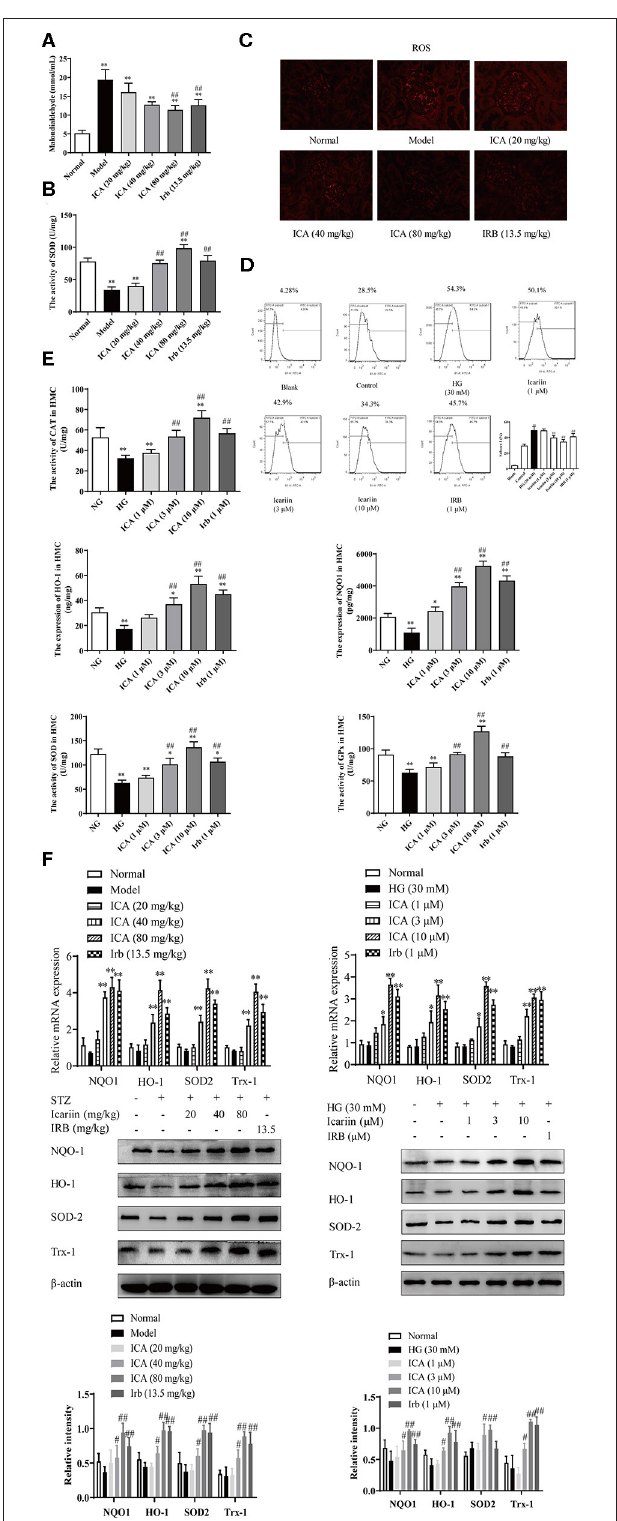
FIGURE 6 | Effect of icariin on oxidative stress in the kidneys of STZ-induced diabetic rats and HMC. (A) Malondialdehyde content (MDA). (B) Superoxide dismutase (SOD) activity. (C) The levels of superoxide anion were detected by